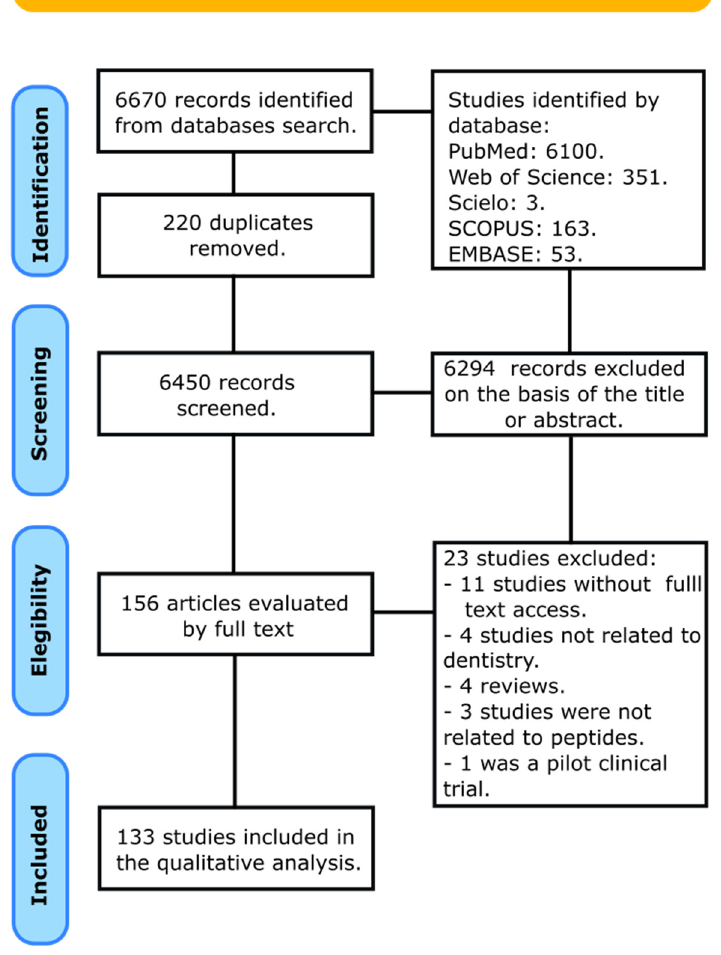
Figure 1. Flowchart summarizing the selection process of articles.